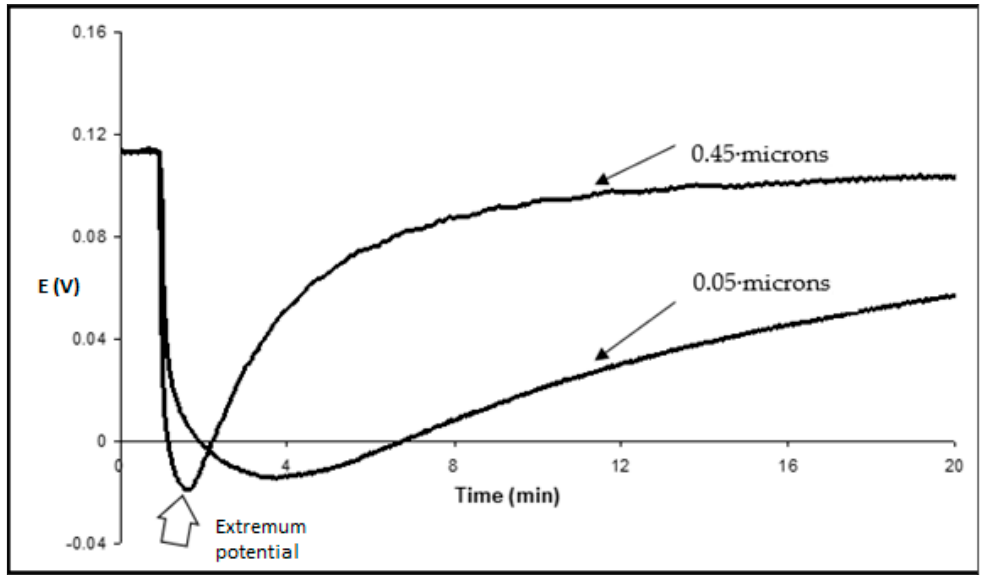
Figure 6. Transmembrane potential as a function of time for impregnated nitrocellulose filters with pore size 0.05 µm and 0.45 µm.